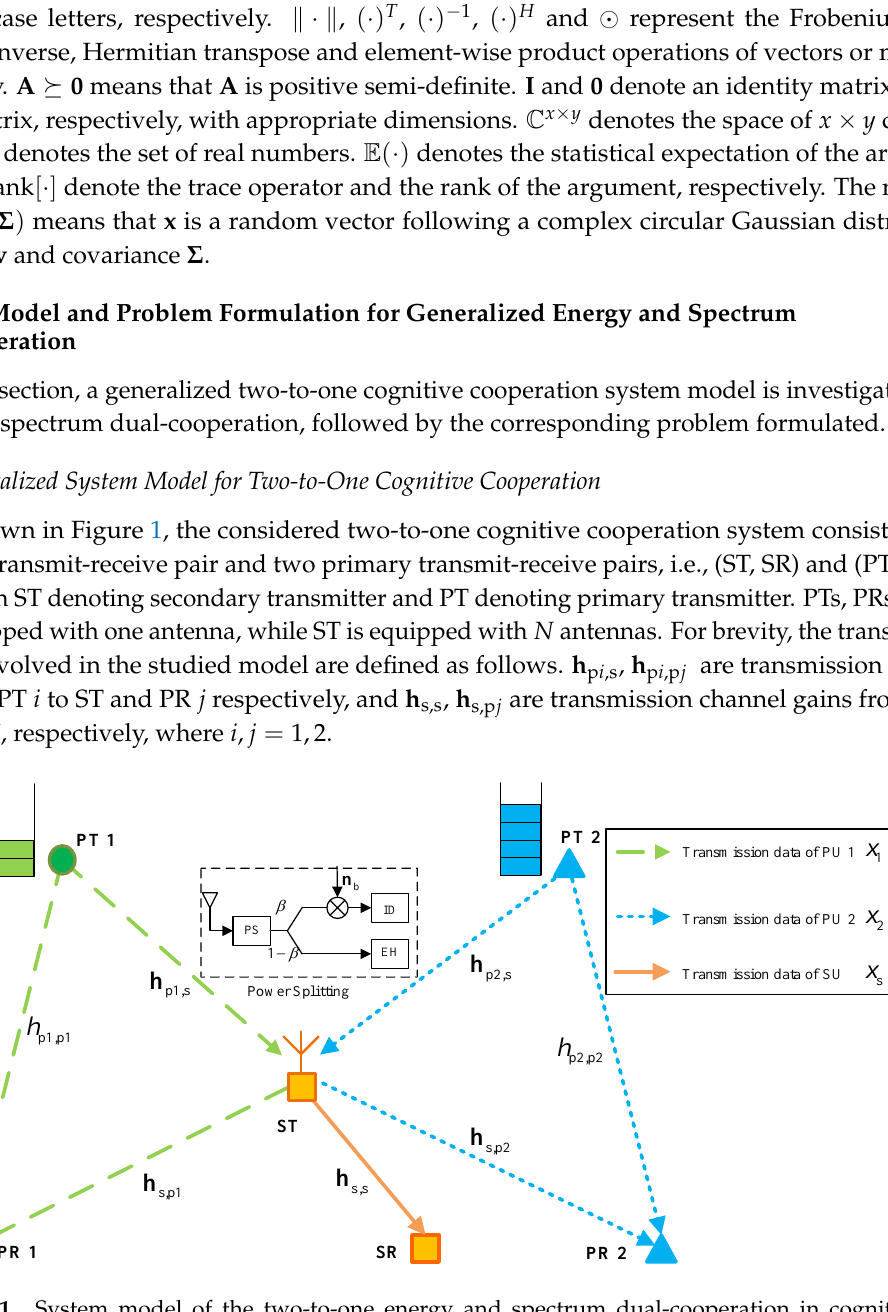
Figure 1. System model of the two-to-one energy and spectrum dual-cooperation in cognitive cooperation